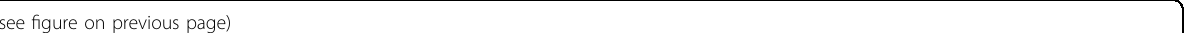
Fig. 4 Neutralization of GW01-related bispeci fi c antibodies against the currently circulating SARS-CoV-2 NAb-escape variants and sarbecoviruses. a Neutralization potency and breadth of mAbs against 56 currently circulating variants. Identi fi cation of putative NAb-escape variants by screening 56 currently circulating SARS2-CoV-2 variants, including B.1.1.7, B.1.351, and B.1.617.2, with sarbecovirus NAbs GW01, 6I18, and S309, as well as SARS-CoV-2 NAbs 3D13, 10C2, 22H22, CC12.1, and COVA1-21. b Bispeci fi c antibody sequence and structure diagram. c Neutralization potency and breadth of GW01-related bispeci fi c antibodies against a panel of 20 NAb-resistant variants, SARS-CoV and 2 bat SARSr-CoVs (WIV1 and Rs3367). d Neutralization of G9 against authentic SARS-CoV-2 and its variants B.1.1.7, B.1.351, B.1.617.2, and B.1.525, and authentic GX-pangolin. e Binding af fi nities of G9, GW01, and S309 binding to RBD proteins of fi ve sarbecoviruses. f Neutralizing mechanism of bispeci fi c antibody G9. Key mutated residues that can affect the neutralizing activity of the antibodies are mapped on the RBD. The purple block is for REGN10989, the blue block is for GW01, and the green block is for both REGN10989 and GW01. The black dotted line indicates the epitope of GW01 on RBD (orange). The epitope of REGN10989 is based on the results of hydrogen-deuterium exchange mass